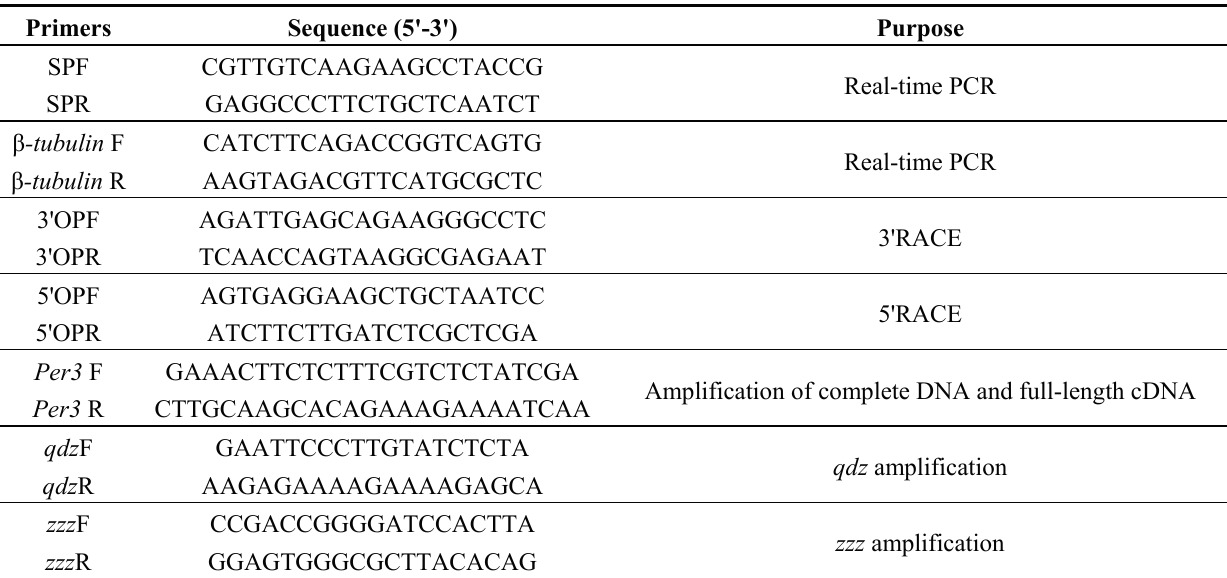
Table 3. Primers used in the